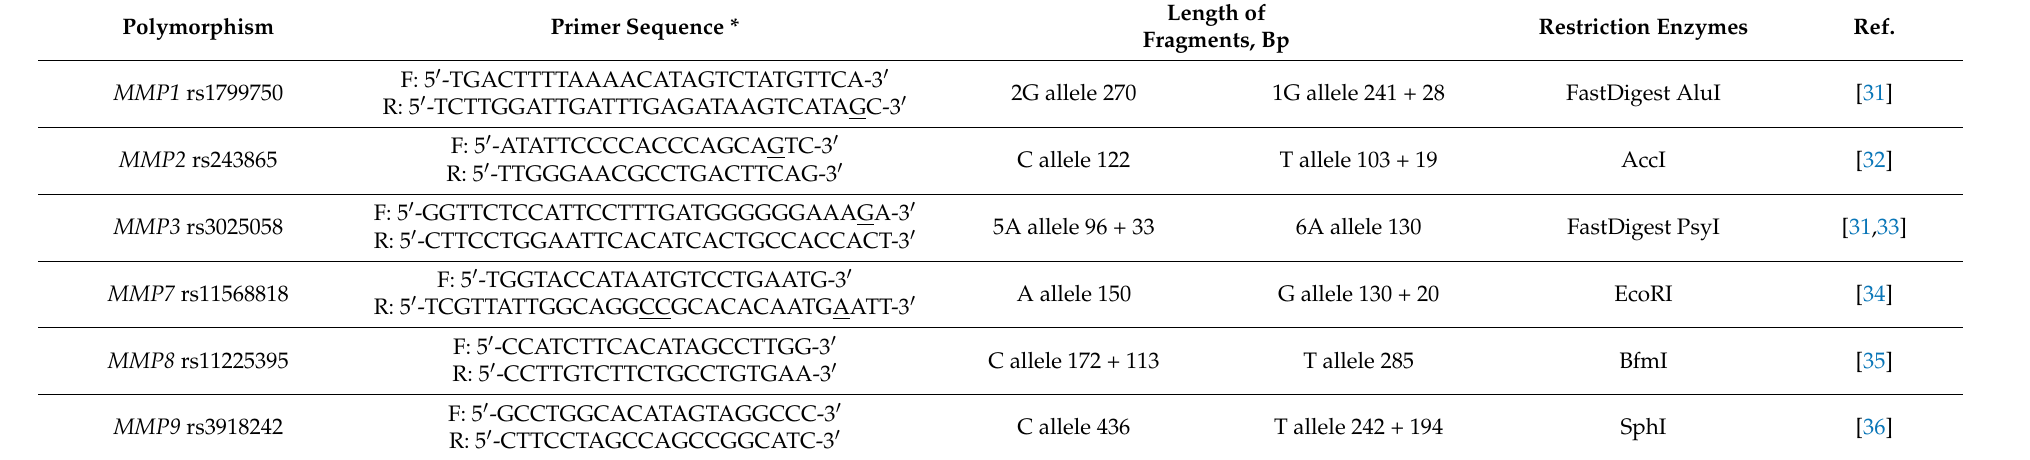
Table 1. Primer sequences for analyzed gene polymorphisms, length of PCR–RFLP products, and restriction